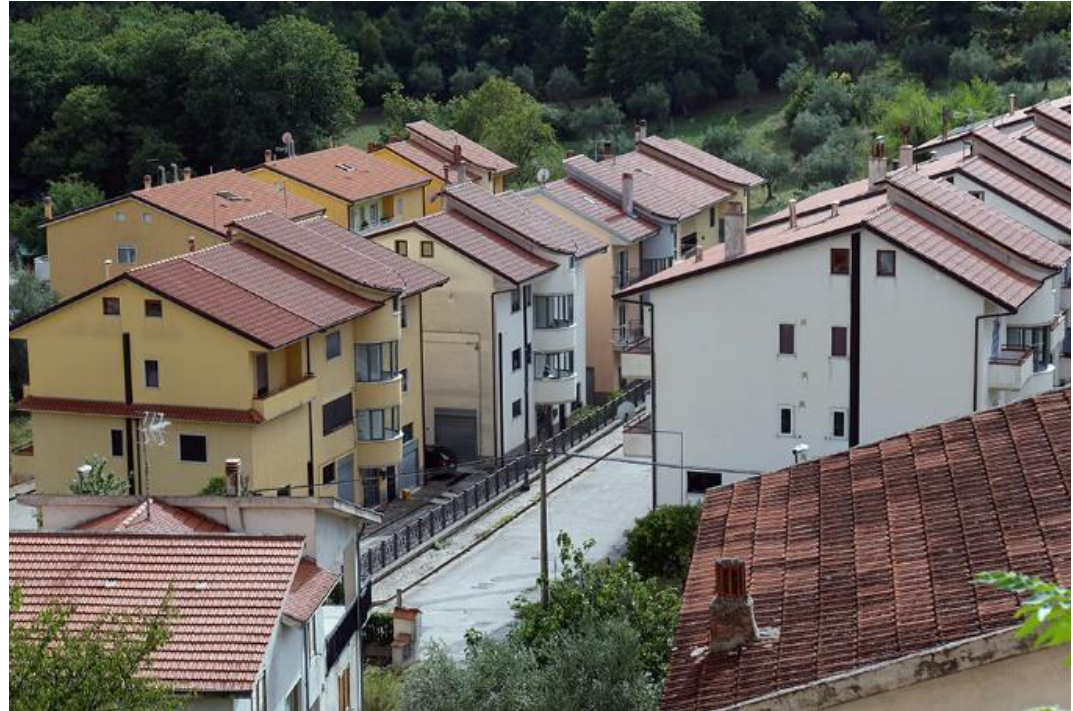
Figure 93. Salvitelle: details of new buildings (photos by [35,36]).